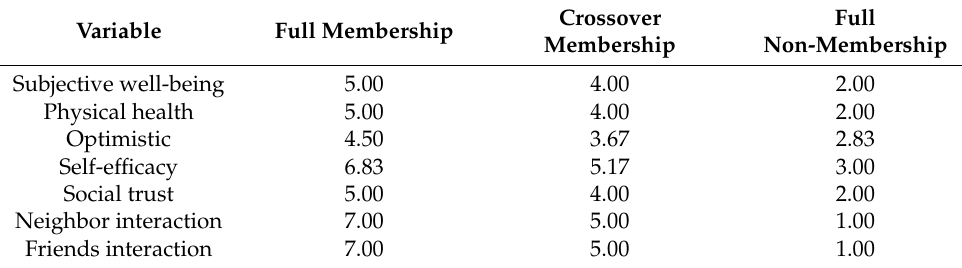
Table 2. Calibration of conditional and outcome